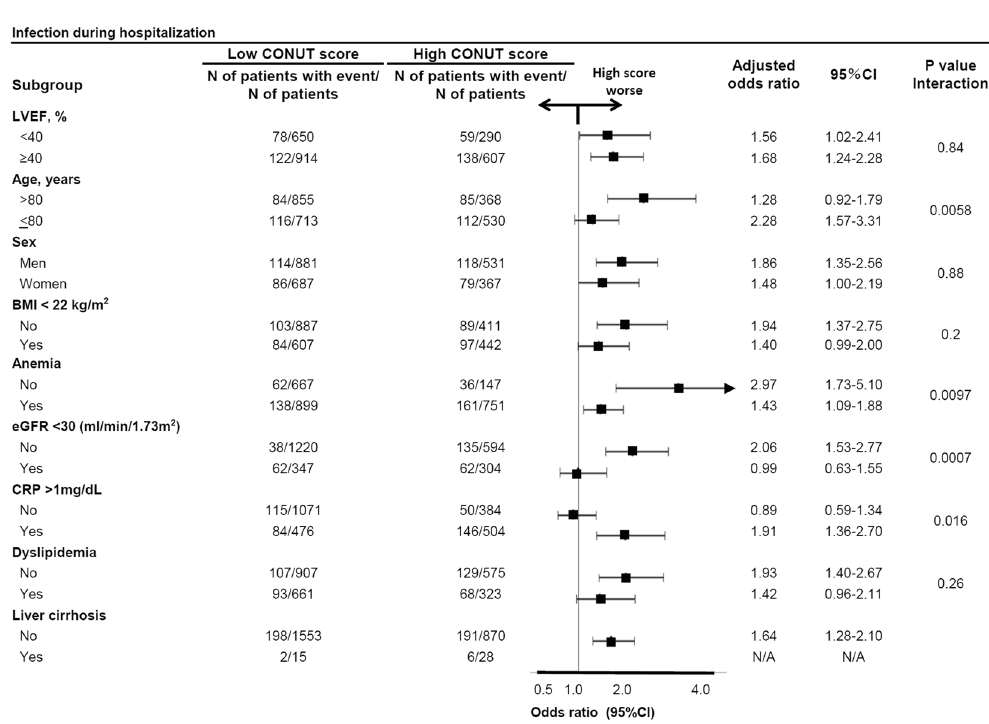
Figure 4. Subgroup analysis for the effect of the high versus low CONUT score on the infection during hospitalization. CONUT = Controlling Nutritional Status, CI = confidence interval, LVEF = left ventricular ejection fraction, BMI = body mass index, eGFR = estimated glomerular filtration rate, CRP = C reactive